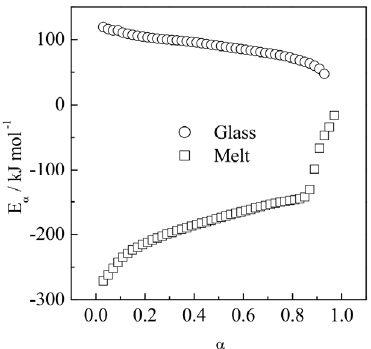
Figure 4. Isoconversional activation energies estimated for crystallization of poly(ethylene terephthalate) by cooling from the melt state ( squares) and by heating from the glass state (circles). Adapted with permission from Vyazovkin et al. [35,54] Copyright 2002, 2006 Wiley ‐ VCH.